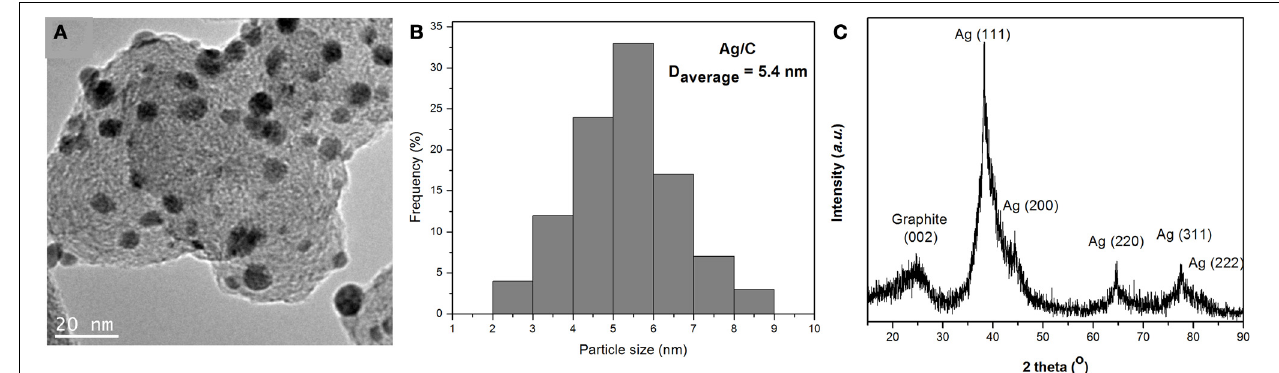
FIGURE 1 | TEM image (A), particle size histogram (B) and XRD patterns (C) of Ag/C catalyst.